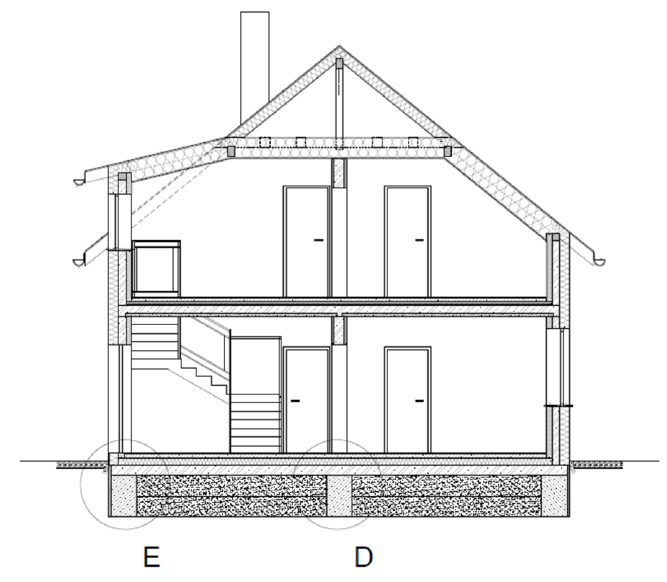
Figure 10. Cross section showing the location of details D and E.